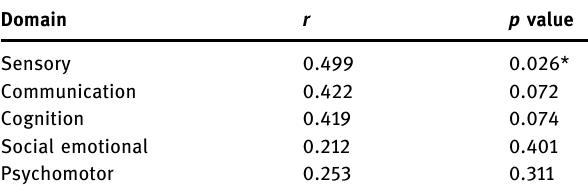
Table 10: Partial Pearson correlation between the number of interactions with Kaspar and the change in domain scale scores, controlling for the number of months in the study